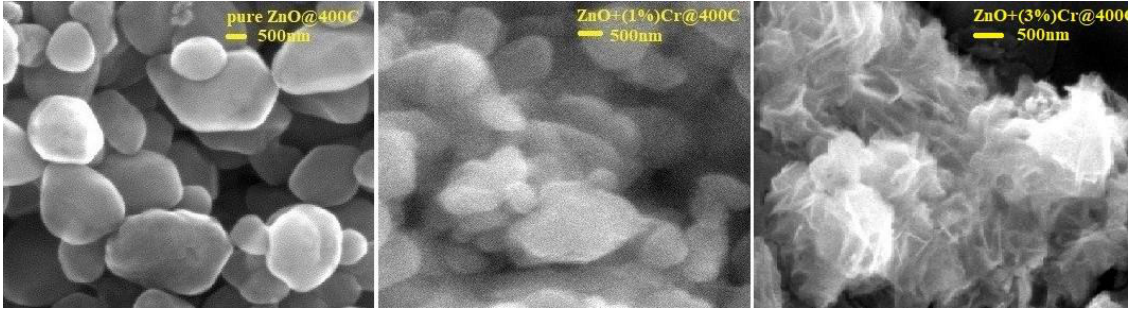
Figure 5. FESEM image of Zn (1-x) Cr x O (x = 0, 0.1 and 0.3) nanoparticles